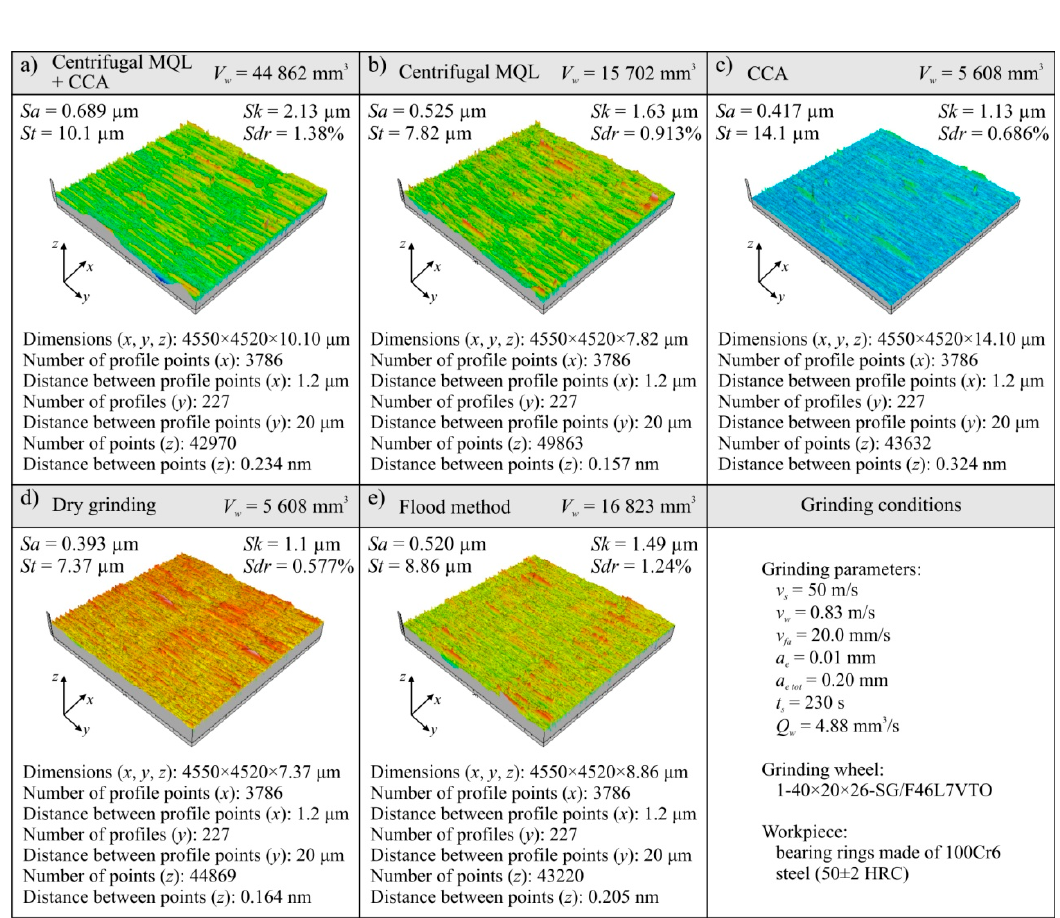
Figure 6. Microtopographs and selected surface roughness parameters of the last ground workpieces from the grinding wheel’s service life: ( a ) hybrid method of cooling and lubrication (centrifugal MQL + CCA); ( b ) centrifugal MQL; ( c ) CCA; ( d ) dry grinding; ( e ) flood method.